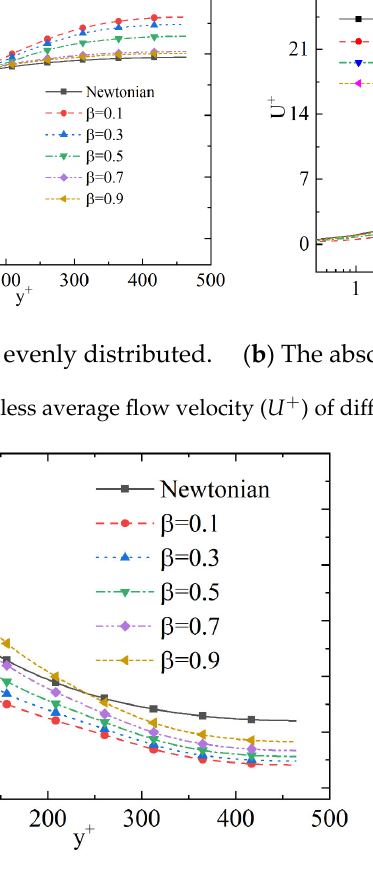
k  ) of different solvent viscosity ratios (  ).